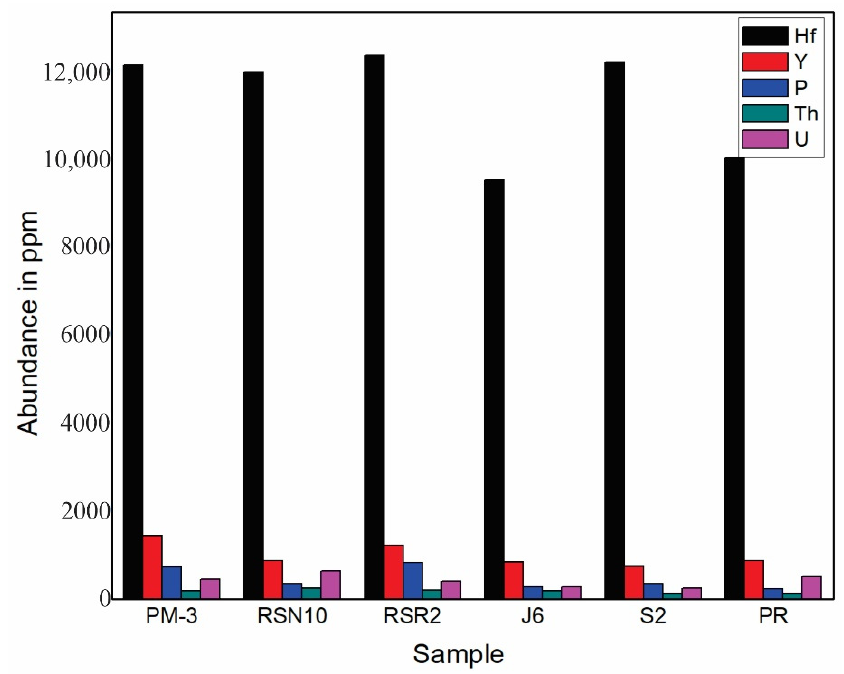
Figure 4. Abundance of trace elements and radioactive elements from different samples of sand.